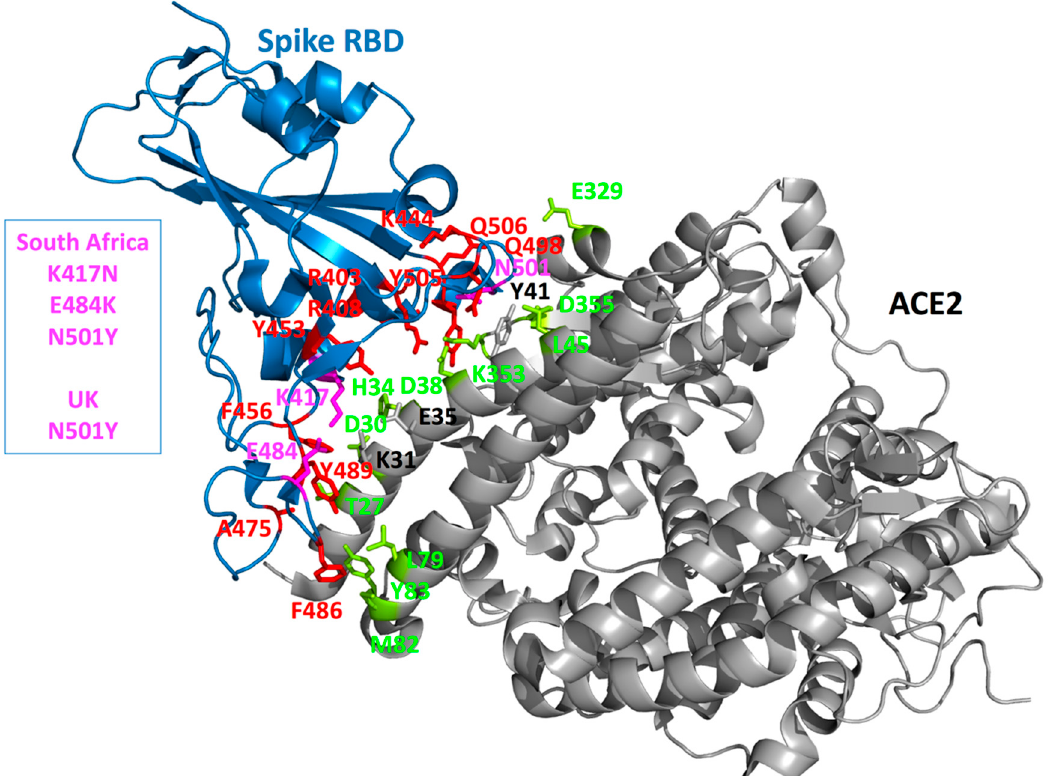
Figure 5. Mapping key amino acids at the Spike–ACE2 interface. The crystal structure of the Spike RBD and part of the ACE2 receptor interacting with the Spike is shown as cartoon diagram (PDB entry 6M0J). The Spike domain is in blue and the ACE2 domain in grey. The Spike side chains predicted to be energetically important (with our in silico protocol, see the Method section) for the interaction with ACE2 are shown in red. The UK and/or South African strains are highlighted by coloring the amino acids in magenta. All the Spike side chains shown here should have favorable interaction energies with ACE2 but E484 that is predicted to have very weak or unfavorable interactions. On the ACE2 side, the side chains that are predicted to contribute favorably to the interaction with the Spike RBD are shown in lemon yellow. Only ACE Y41 (in grey) seems to have very limited interactions with the Spike protein while, when the Spike protein carries a Y at position 501, ACE2 Y41 has then some favorable interaction energy values with the Spike. Two other ACE2 residues can be mentioned here, K31 and E35 (in grey, see Text).